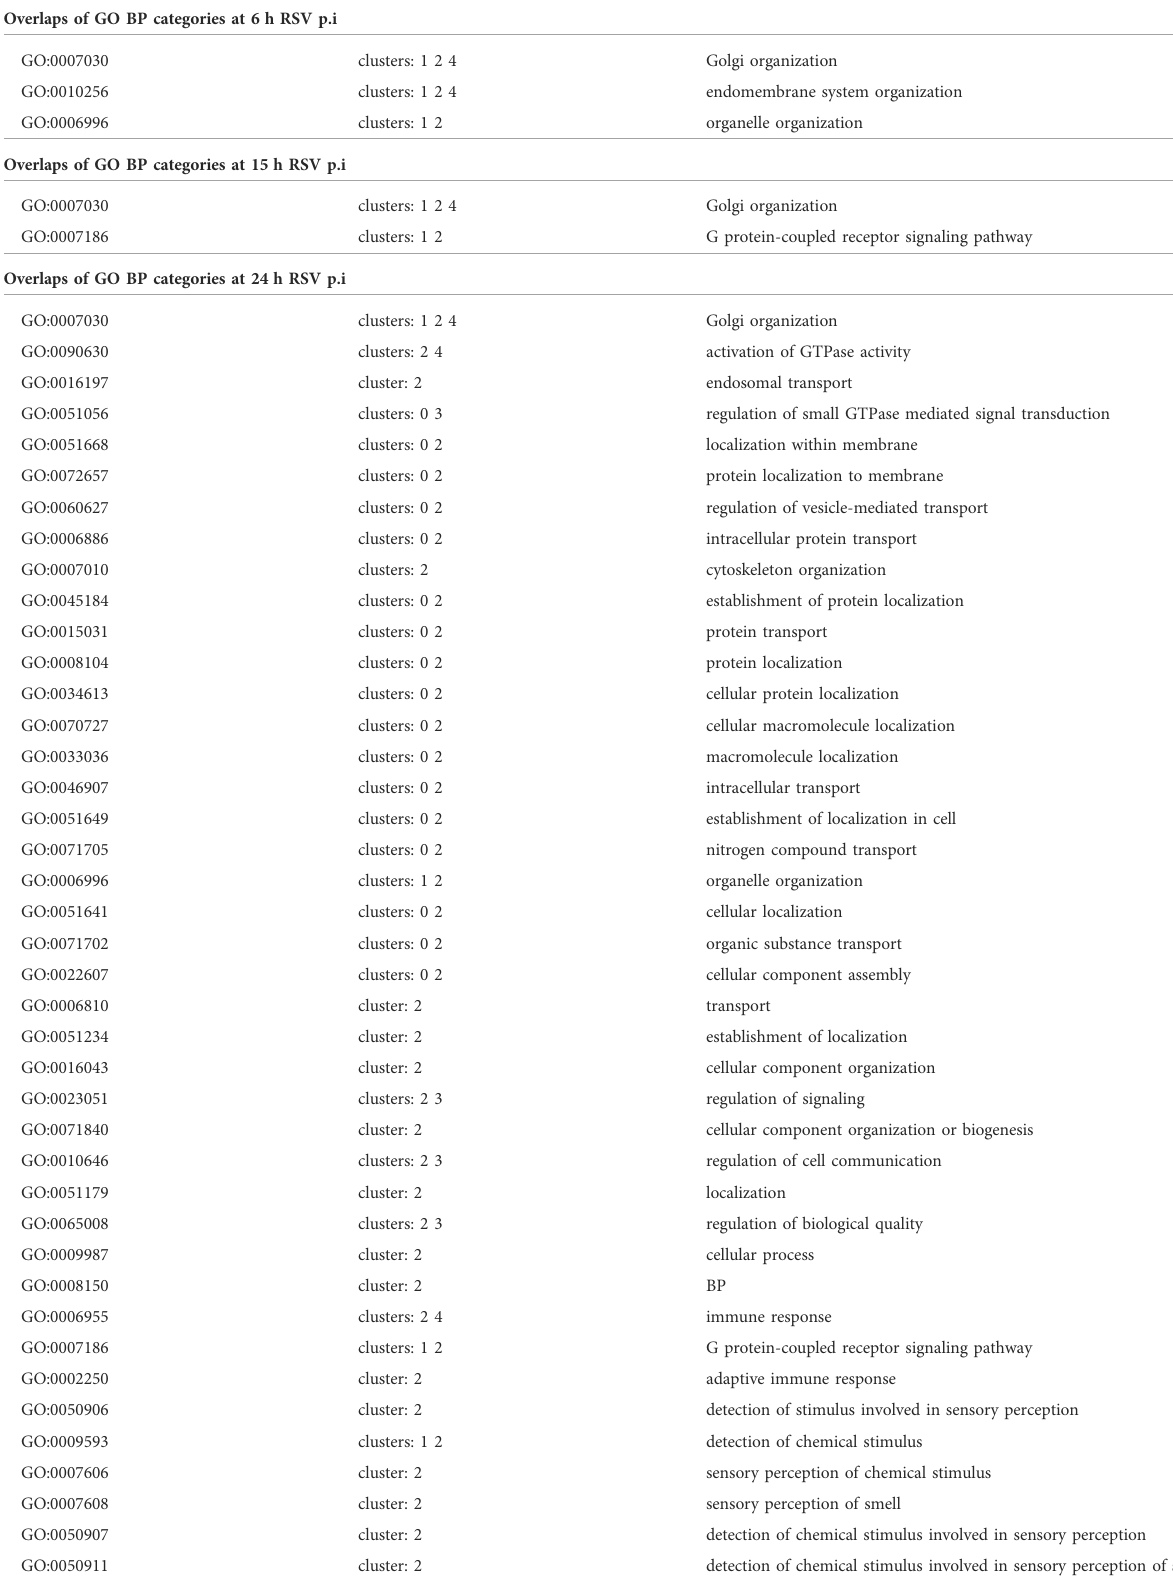
TABLE 6 Correlation of Gene Ontology (GO) biological processes (BP) subset categories with the clustering of the temporal pro fi les of X -axis. Overlaps of GO BP categories at 6 h RSV